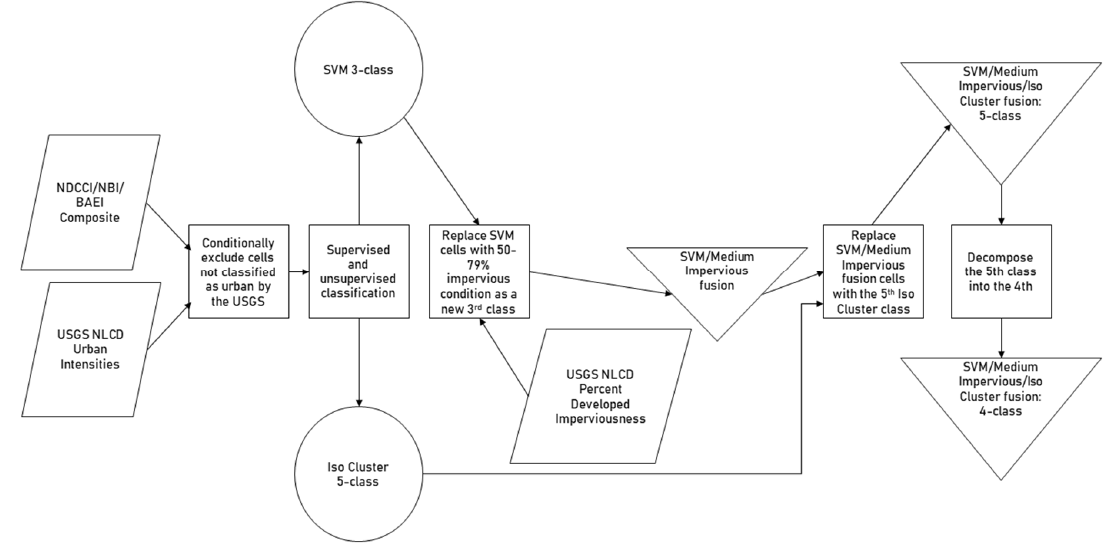
Figure 4. Urban intensity classification workflow diagram.